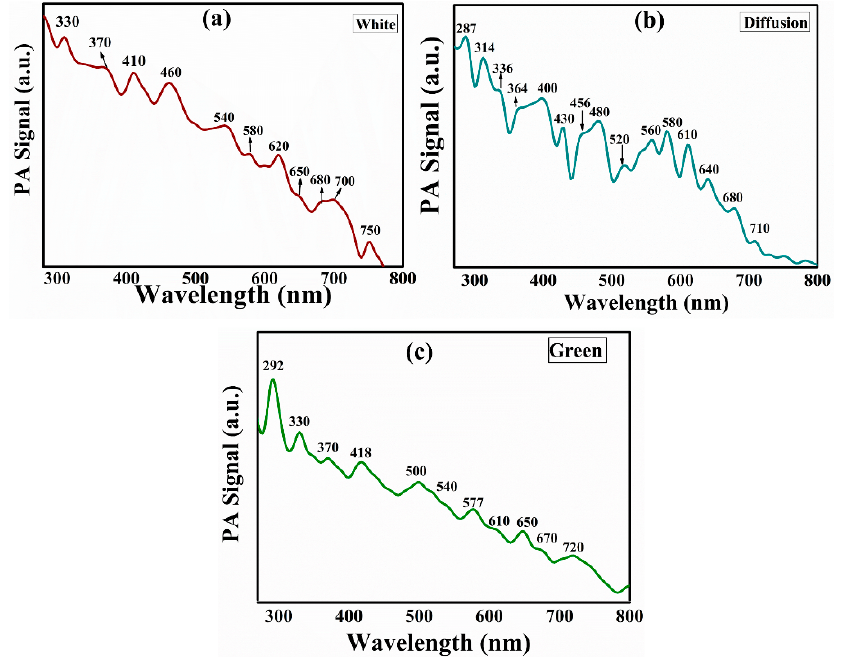
Figure 8. Photoacoustic spectra of quartz-fluorite sample recorded for ( a ) white zone, ( b ) diffusion zone, and ( c ) green zone.